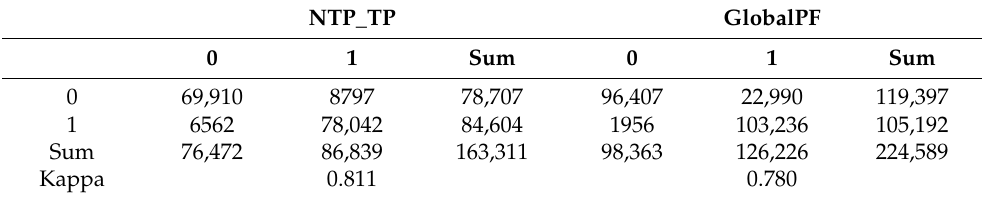
Table 2. Kappa coefficients of the NPD_TP and GlobalPF and this study. The first column presents the calculated result in this study, and the rows present the classification in NPD_TP and Glob- alPF, respectively.